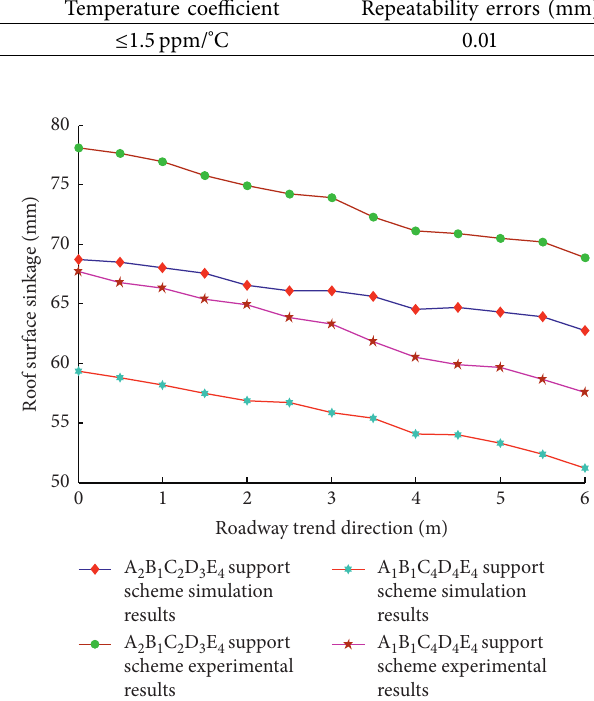
Figure 12: Comparison of experimental results and simulation